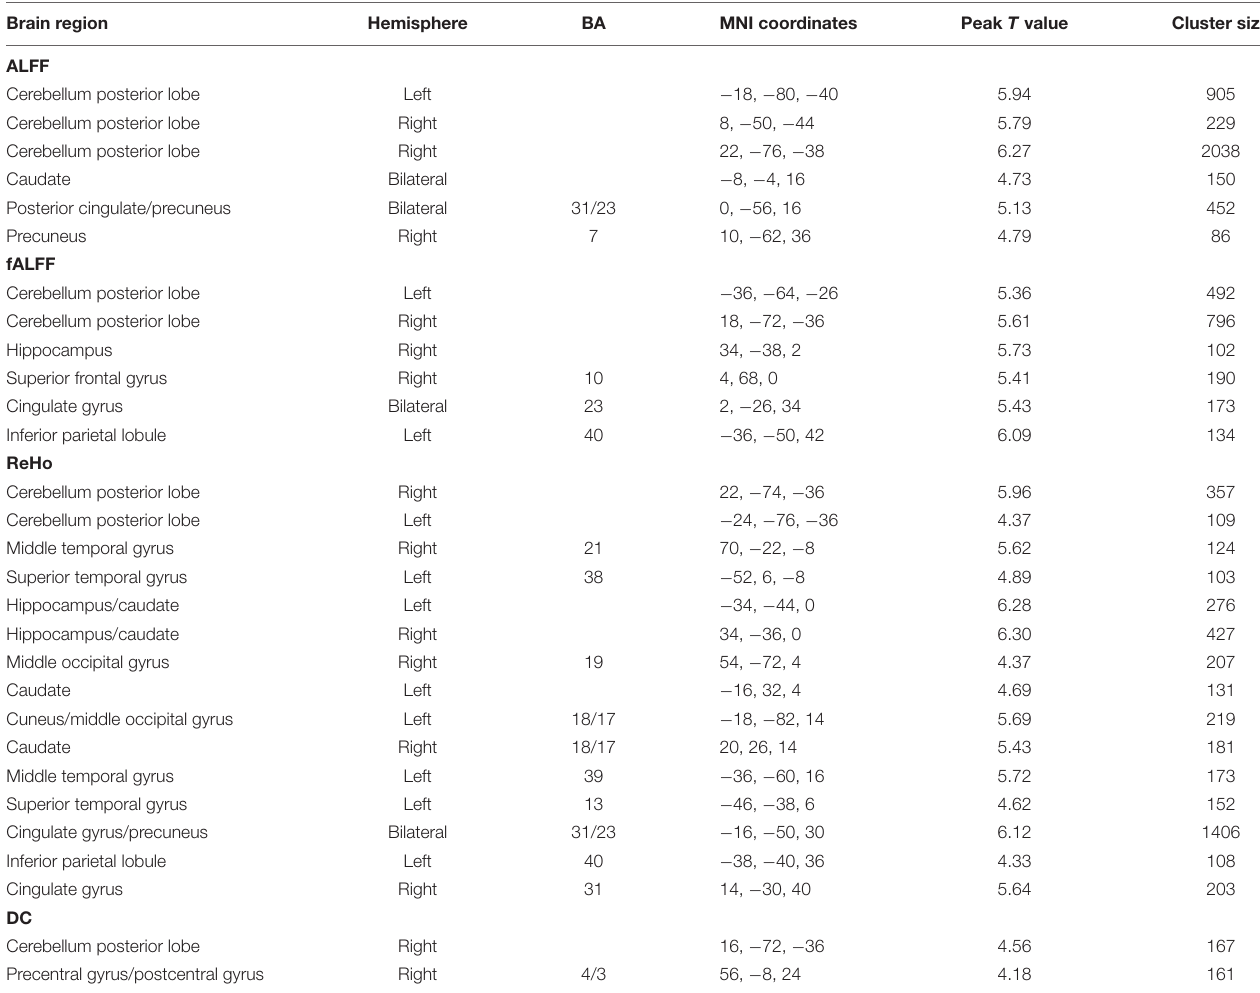
TABLE 3 | Regions showing significant gender differences (female > male) for each index. Brain region Hemisphere BA MNI coordinates Peak T value Cluster